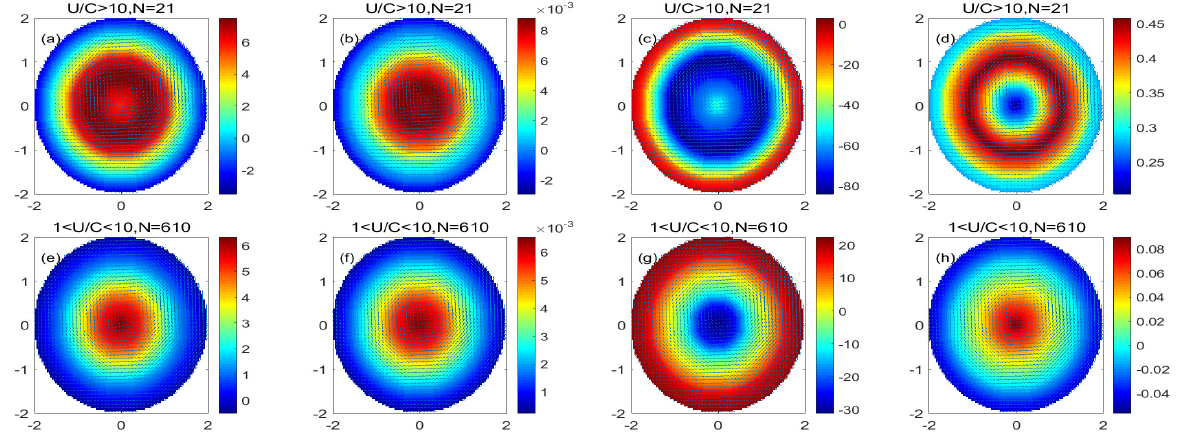
Figure 7. ( a − d ) are the monopole distribution of the PP variation, POC variation, PP/Chl, and PP/POC in a high nonlinear cyclonic eddy, respectively; ( e − h ) are the monopole decomposition of the PP variation, POC variation, PP/Chl, and PP/POC in a low nonlinear cyclonic eddy, respectively. (Unit: mg/m 3